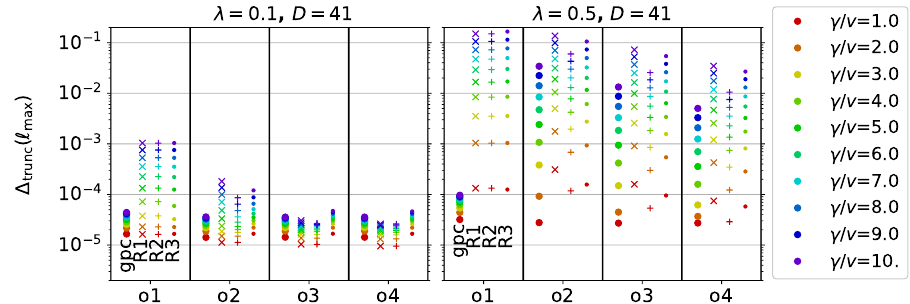
( ℓ ) between exact spectrum of the truncated trunc max